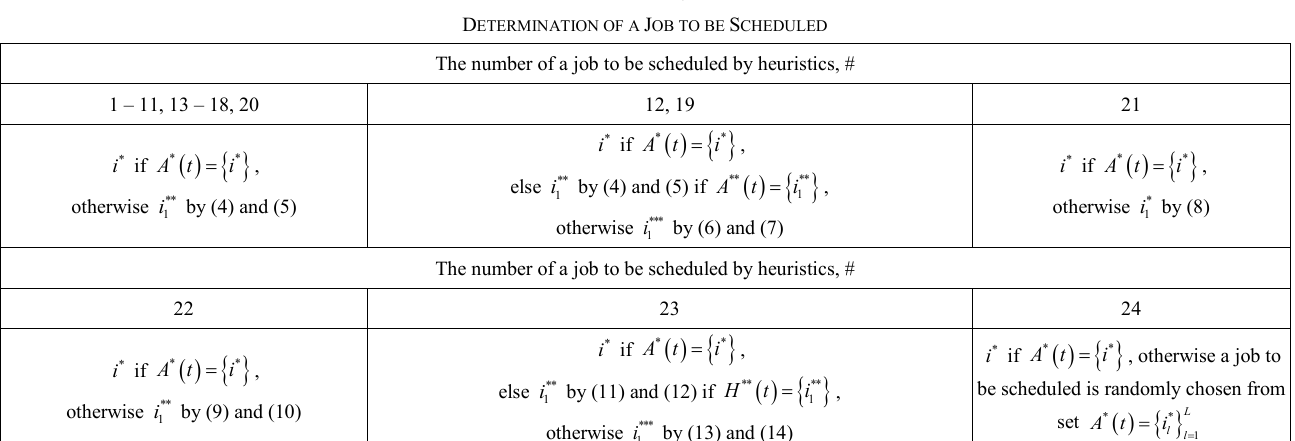
D ETERMINATION OF A J OB TO BE S CHEDULED